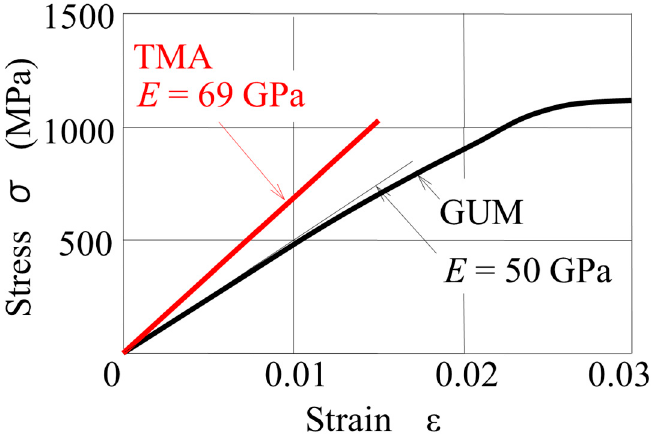
Figure 2. Stress–strain curves of GUM and TMA.